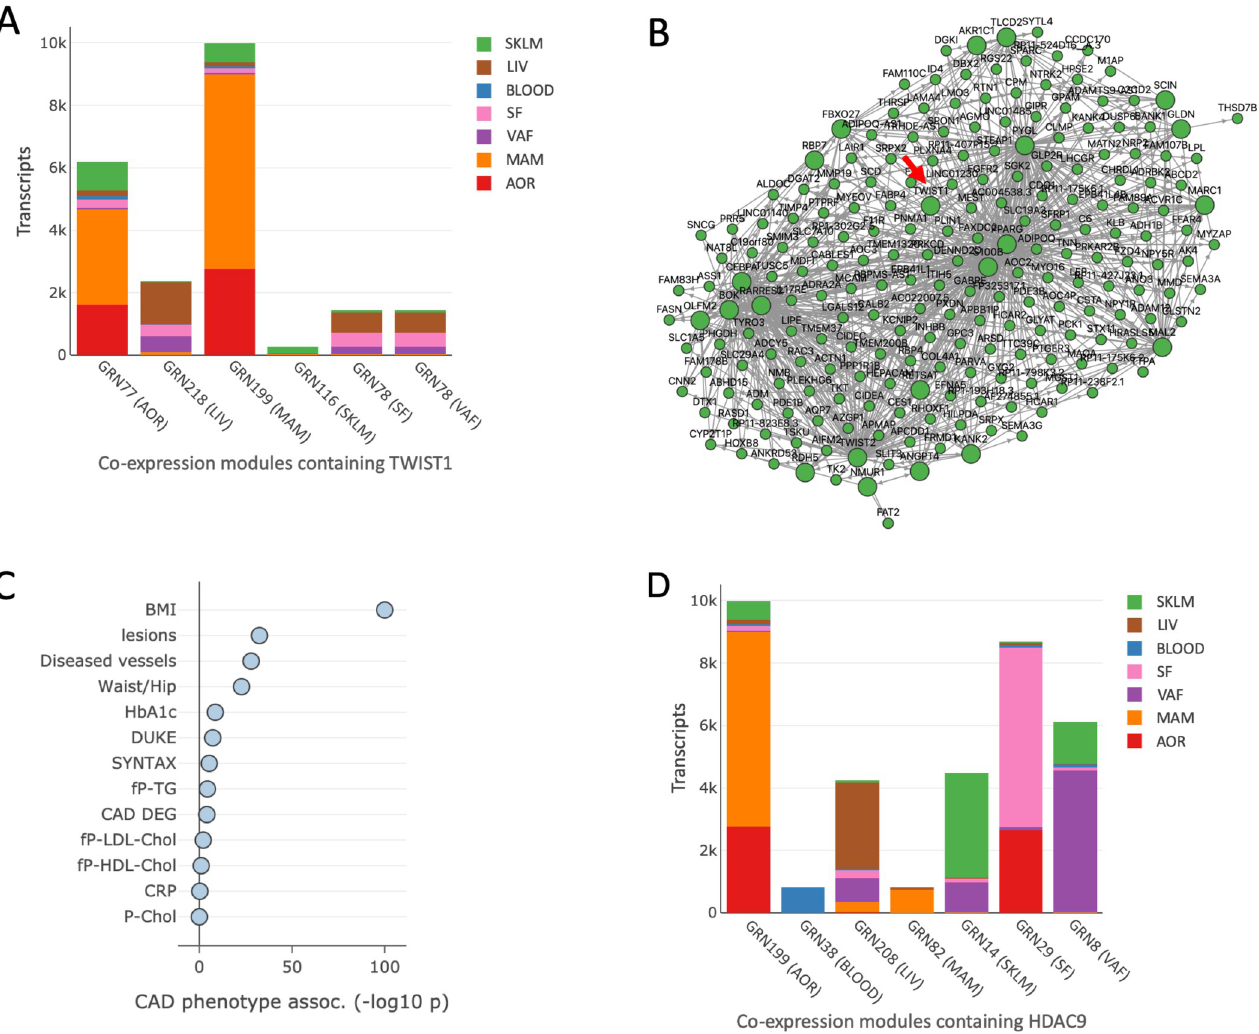
Fig 7. GRNs involving TWIST1 or HDAC9 and their associations in STARNET tissues. GRNs were generated from AOR, MAM, BLOOD, LIV, SKLM, SF and VAF tissues in STARNET as described [10]. (A) Of a total of 224 GRNs identified across these STARNET tissues, TWIST1 was found in 5 (GRNs 77, 78, 116, 199, 218), where it acted in AOR, MAM, LIV, SKLM, SF and VAF ( TWIST1 acted in GRN 78 in both SF and VAF). Color codes represent differing tissues acquired in the STARNET study, while the tissue named on the horizontal axis (i.e. GRN 77 (AOR)) indicates the tissue containing TWIST1 in that particular GRN. The vertical axis (‘Transcripts’) represents the total number of transcripts in each module. (B) Visualization of GRN 116, with TWIST1 identified as hierarchically being among the top key drivers as indicated by red arrow (P = 1.63 x 10 − 32 ). This GRN contains 279 genes, with 77.1% being in SKLM (including TWIST1 ), 15.8% in MAM, 3.9% in AOR and a smaller proportion in SF, BLOOD and LIV. Apart from GRN 116, TWIST1 was not a key driver in any other GRNs. (C) Association of GRN 116 with clinical traits assessed in the STARNET study [10]. CAD DGE represents the enrichment of differential gene expression in the module between cases and controls. GRN 116 was associated with certain metabolic indices and also with the severity of CAD as assessed by number of coronary lesions (“lesions”), number of diseased vessels (“Diseased vessels”), SYNTAX score (“SYNTAX”) and Duke CAD index. (D) GRNs involving HDAC9 in STARNET. HDAC9 was found in 7 different GRNs (GRNs 8, 14, 29, 38, 82, 199, 208), where it acted in AOR, MAM, LIV, SKLM, BLOOD SF and VAF, but it was not a key driver in any of these networks. These data are also available from the dedicated STARNET website described in Koplev et al (starnet.mssm.edu)